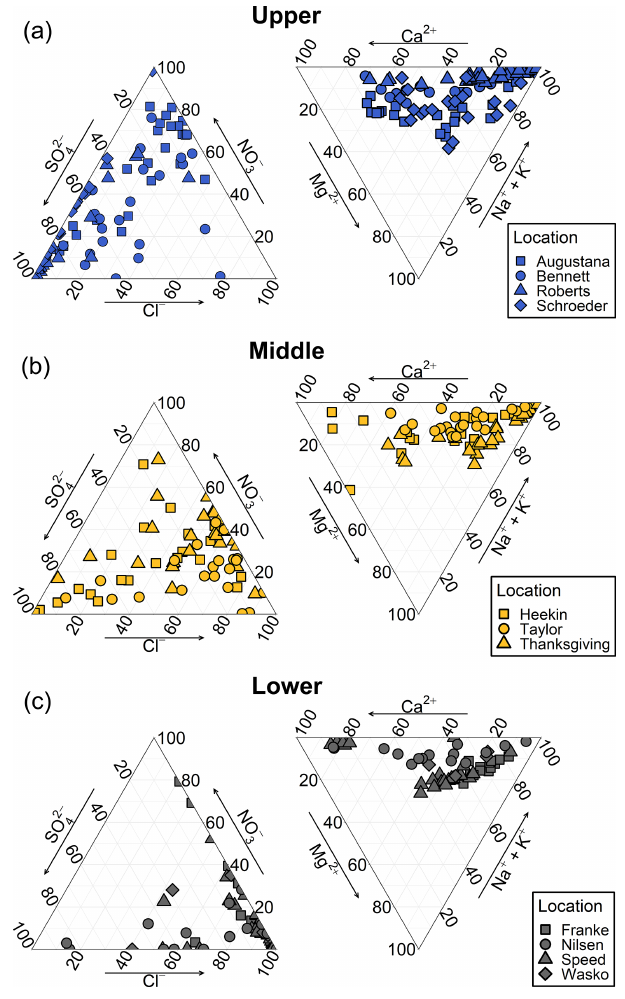
Figure 3. Anion and cation ternary diagrams for the three geo- graphic zones.